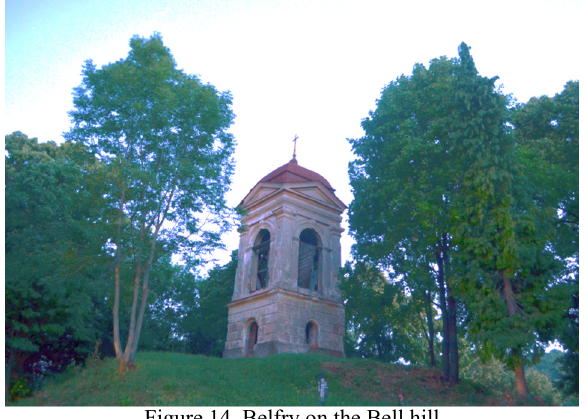
Figure 14. Belfry on the Bell